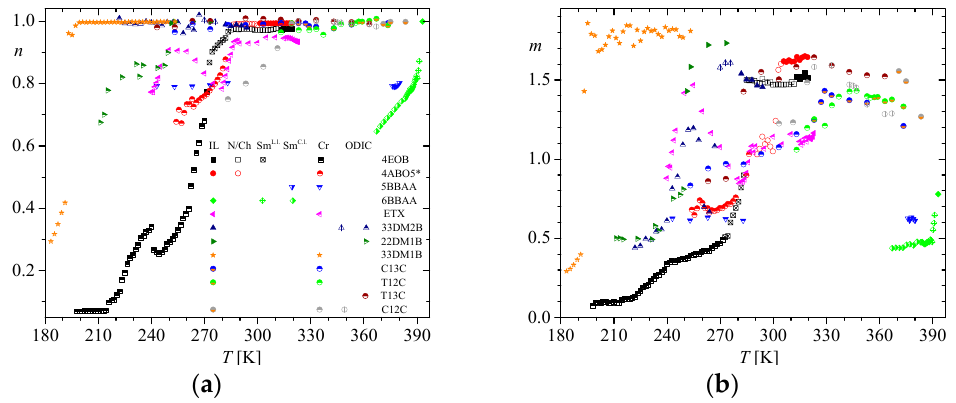
Figure 3. Experimental values of ( a ) exponent n and ( b ) exponent m for selected compounds in various thermodynamic phases. Sm L.l. means smectic liquid-like phases (here SmA and SmX). Sm C.l. means smectic crystal-like phases (here SmB).